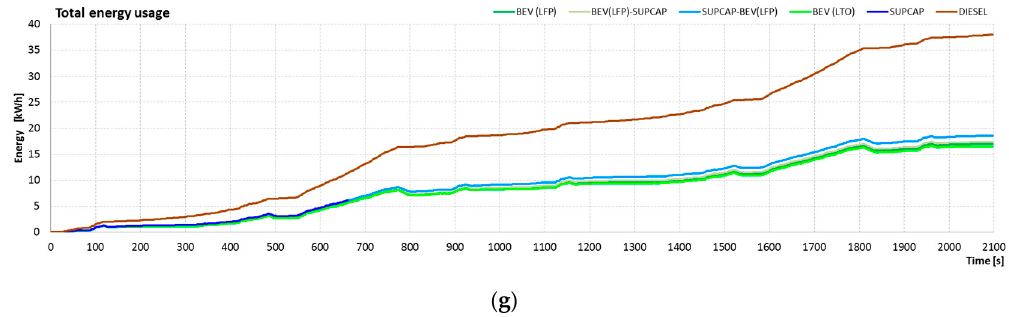
Figure 15. UDDS-HD results of simulation tests, where: ( a ) Bus speed during tests (km/h); ( b ) Voltage and Current on DC-link (V), (A); ( c ) Motor/Engine Power (kW); ( d ) Battery & SUPCAP State of Charge (%); ( e ) Battery & SUPCAP temperature (°C); ( f ) Instantaneous energy consumption (Wh/km); ( g ) Total energy usage (kWh).